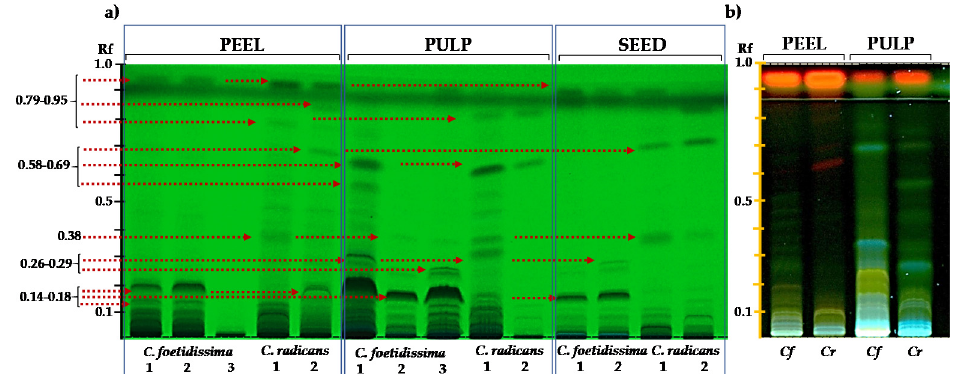
Figure 3. Saponin/cucurbitacin profiles of wild Cucurbita species. Saponin/cucurbitacin profiles of seeds, pulp and peel of C. foetidissima and C. radicans fruits were obtained by HPTLC analysis. The fruits were sampled in 2018 from plants growing in the wild in two different locations in the state of Jalisco, M é xico: Vaquer í as, municipality of Ojuelos ( C. foetidissima ) and San Jos é de Gracia, municipality of Tepatitl á n ( C. radicans ). In ( a ) the TLC-separation of ethanolic extracts was visualized under UV light at 254 nm. The arrows indicate bands whose Rf values corresponded to those of reported cucurbitacins. In ( b ) a similar TLC separation of pulp and peel methanol-chloroform extracts is shown when visualized under UV light (366 nm). Cf = Cucurbita foetidissima ; Cr = Cucurbita radicans . Table 4. Identification of putative cucurbitacins in fruits of wild Cucurbita foetidissima and C. radicans fruits collected in the wild 1 . The retention factors (Rf) were obtained from bands derived from the HPTLC separation of pulp, seed and peel ethanol extracts of C. foetidissima and C. radicans fruits collected from plants growing in the wild in sites localized in the state of Jalisco, M é xico. The Rf values were compared to those reported by R í os et al. [44].